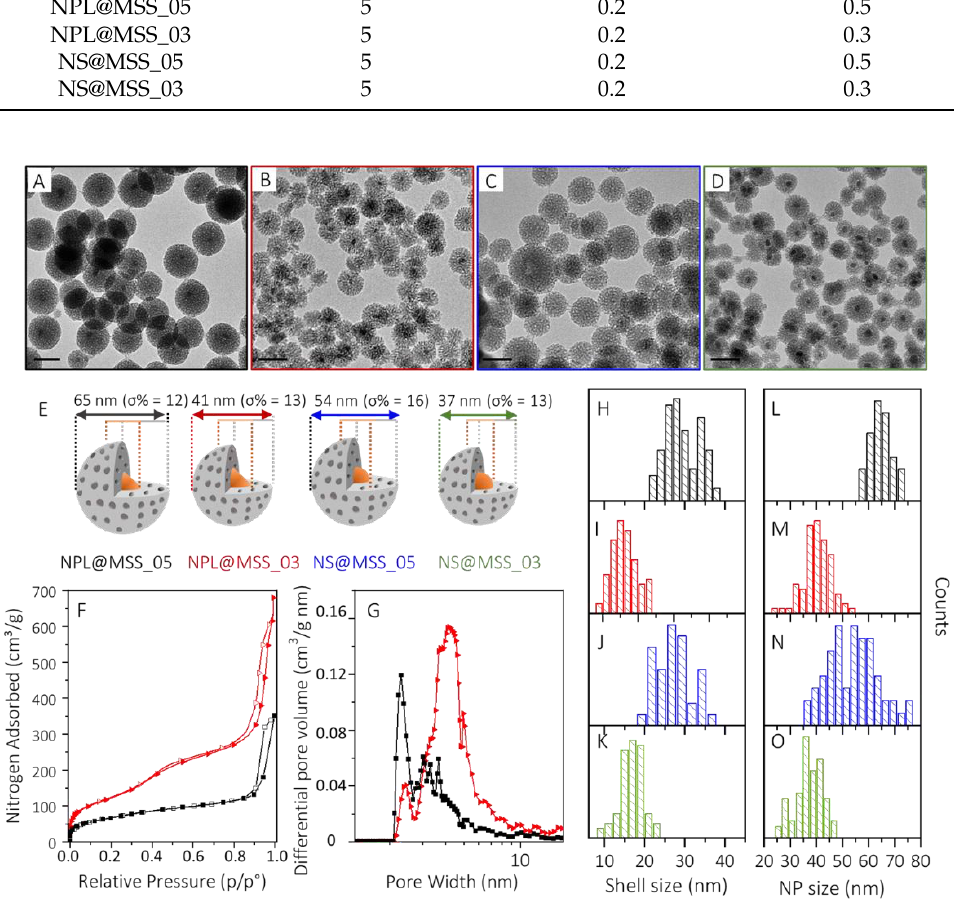
Figure 3. ( A – D ) TEM micrographs (scale bar 50 nm) of NPL@MSS_05 (( A ), black